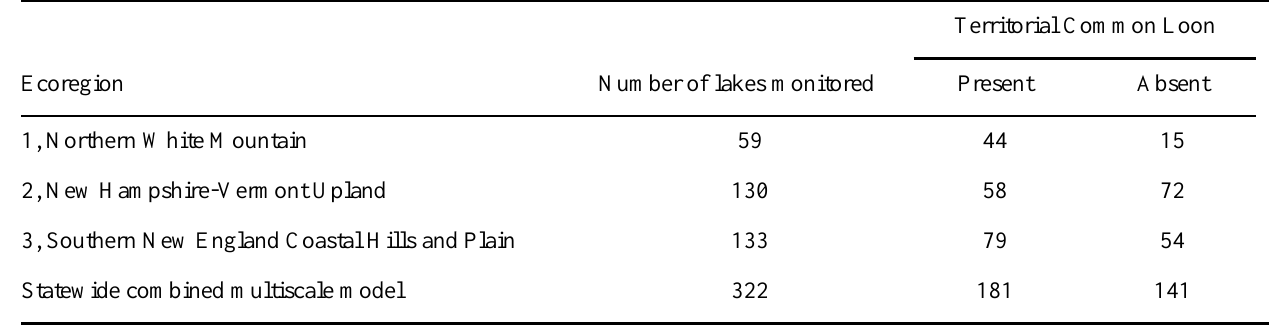
Table 1 . Monitored frequency of occurrence of breeding Common Loon in three New Hampshire physiographic